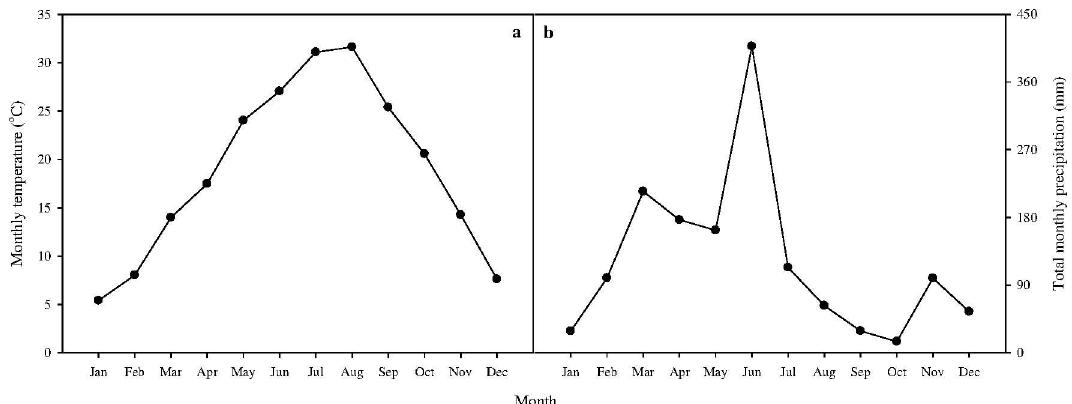
Fig 1. The mean monthly temperature (a) and total monthly precipitation(b) at the experimental